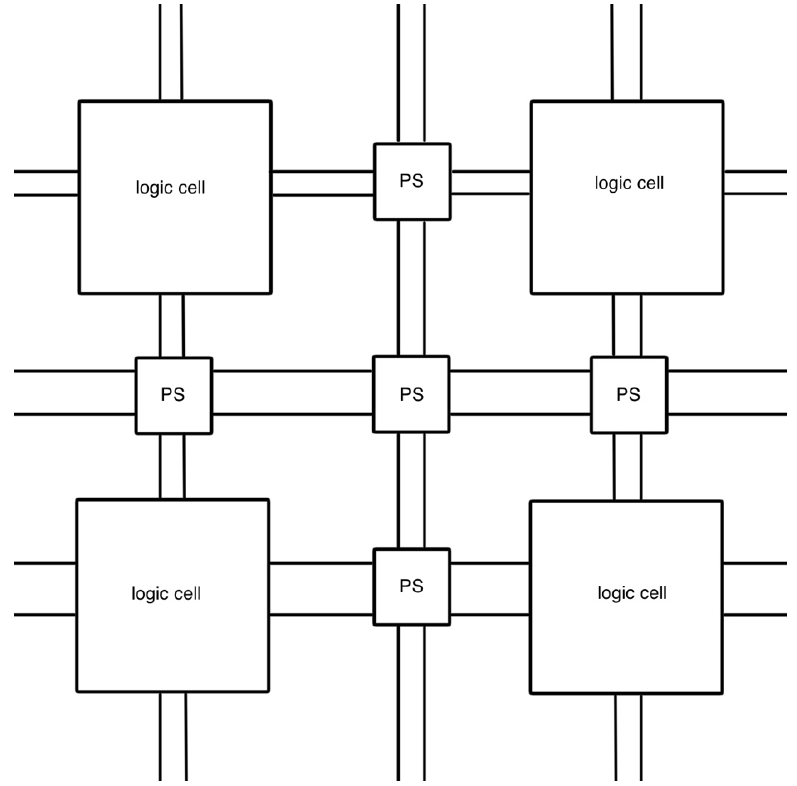
Figure 1. A simplified diagram of FPGA structure.